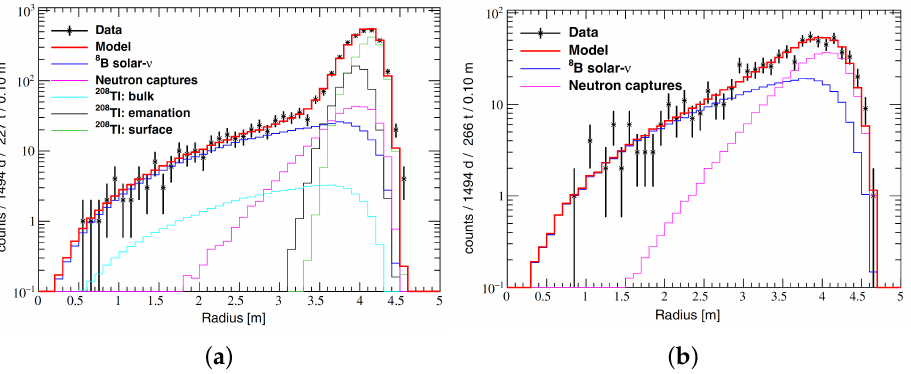
Figure 6. ( a ) Fit of the event radial distribution in the HER-I range, [1650, 2950] p.e., correspond- ing to [3.2, 5.7]MeV. ( b ) Fit of the event radial distribution in the HER-II range, [2950, 8500] p.e., corresponding to [5.7, 16.0]MeV. From